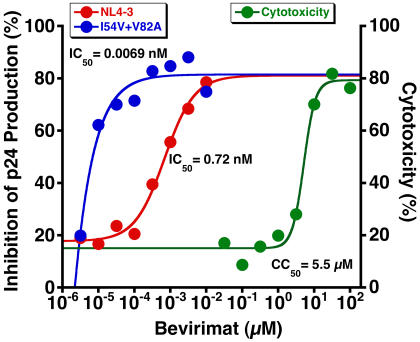
Protease Inhibitor-Resistant HIV-1 with Impaired CA-SP1 Cleavage Is Hypersensitive to Bevirimat In Vitro.NL4-3 PRI54V+V82A is hypersensitive to bevirimat in PHA-activated PBMCs with 50% inhibitory concentration (IC50) >100 times lower than for wild-type NL4-3. CC50 is the 50% cytotoxic concentration as assessed by MTT assay.